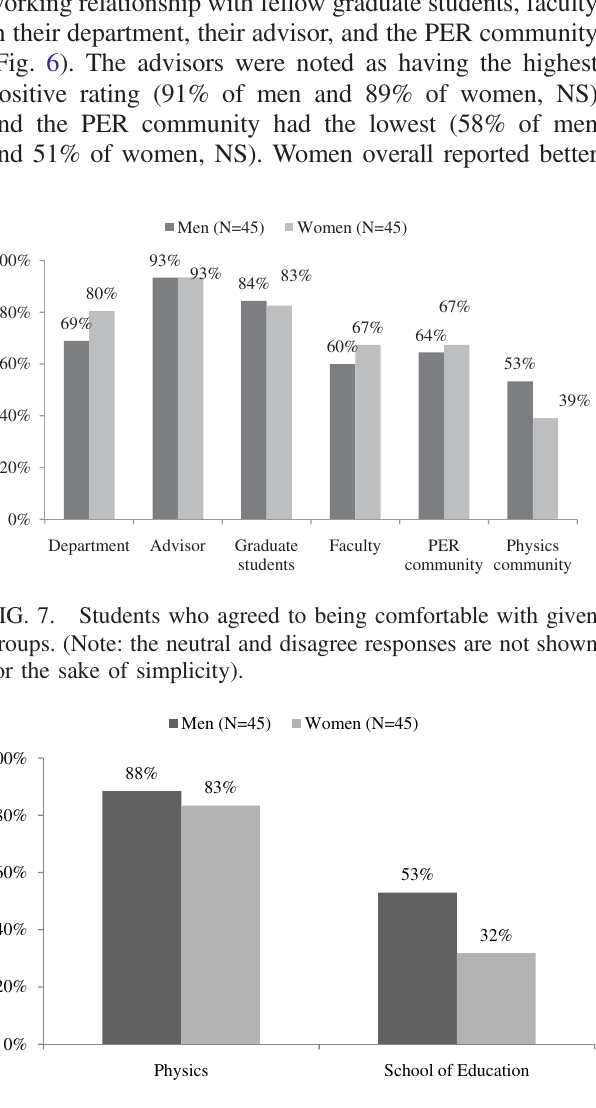
FIG. 6. Students who agreed to having a positive relationship with given groups.